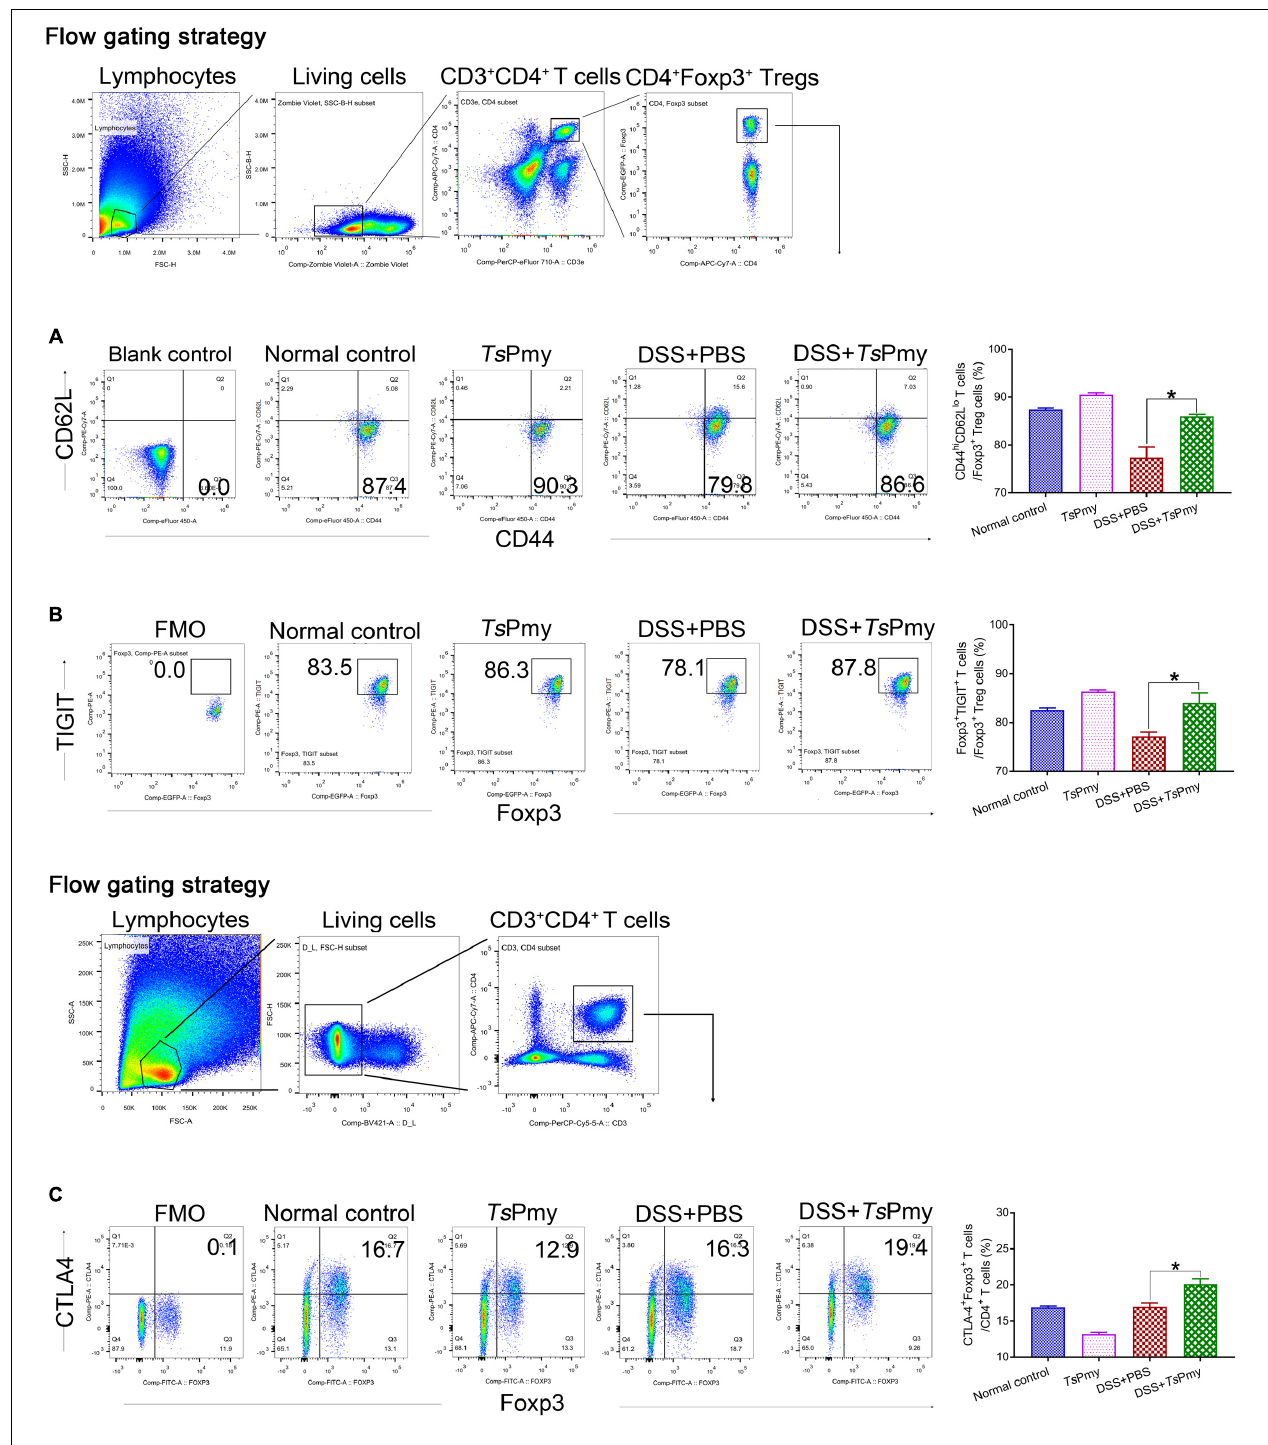
FIGURE 7 | r Ts Pmy maintains majority of Tregs in an effective suppressor status (CD62L lo CD44 hi eTregs) with greater expression of functional phenotypes of TIGIT and CTLA4 in cLP with DSS-induced colitis. Flow cytometry results showed the frequencies of CD44 hi CD62L lo cells (A) and TIGIT + cells (B) in CD4 + Foxp3 + T cells of cLP from r Ts Pmy or PBS-treated mice with or without DSS colitis. The blank control of antibodies of CD62L and CD44 (A) was shown, and the antibody of TIGIT (B) were cut in FMO control samples. The corresponding percentages are shown on the right ( n = 5). (C) The frequency of Foxp3 + CTLA4 + cells in CD3 + CD4 + T cells. The antibody of CTLA4 was cut in FMO control samples. The corresponding percentage is shown on the right ( n = 3–5). The bars represent the mean ± SEM. * p < 0.05. cLP, colonic lamina propria.